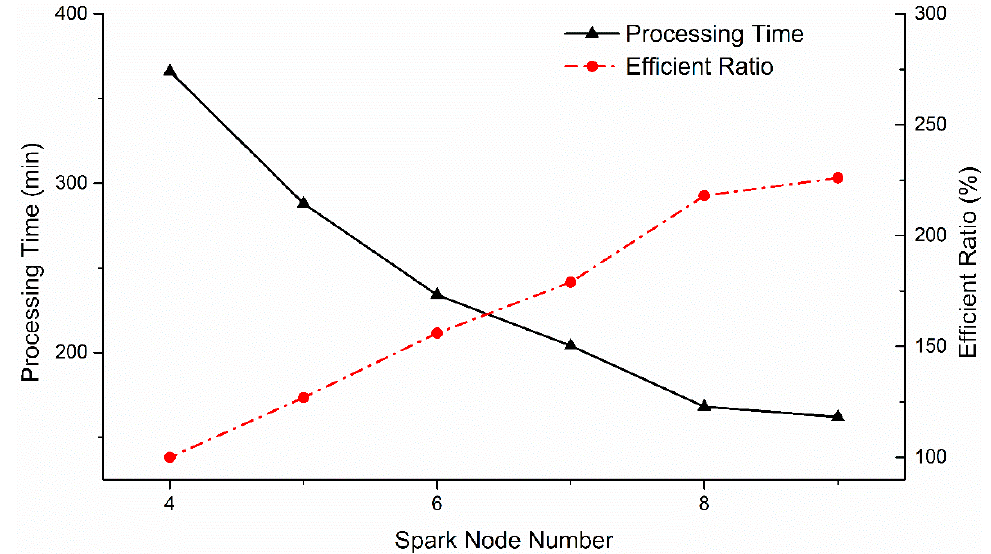
ff erent numbers of Spark worker